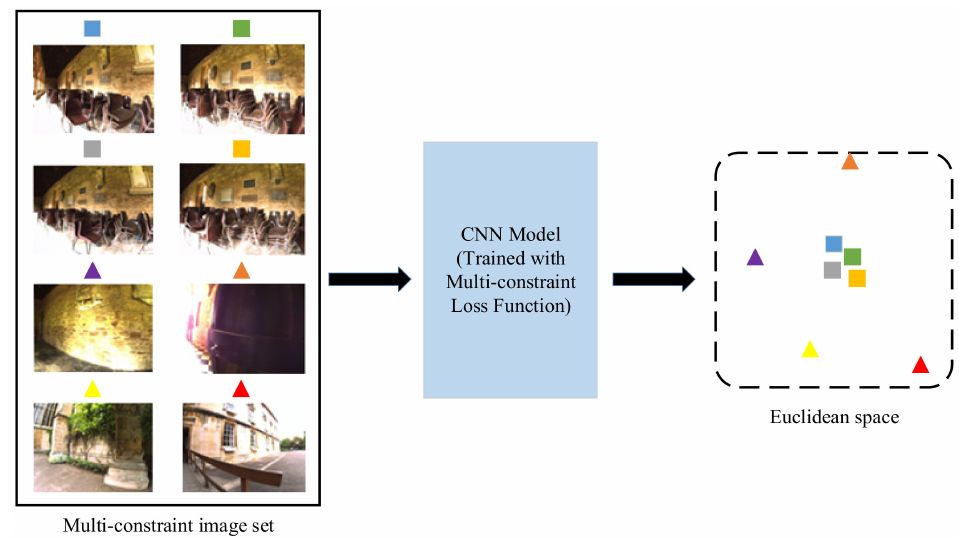
Figure 1. The framework of the proposed multi-constraint deep distance